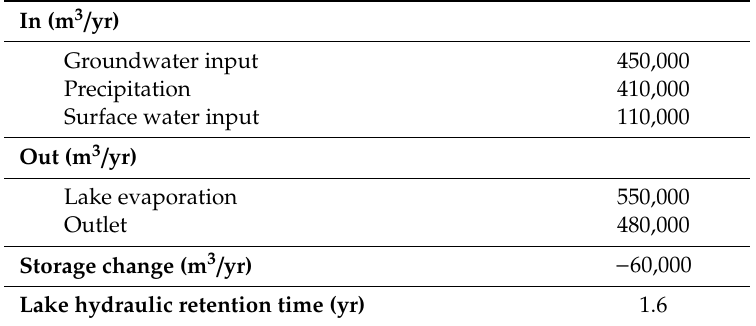
Table 1. Water balance components of Nørresø (6 June 2016 to 21 June 2017, [48]).